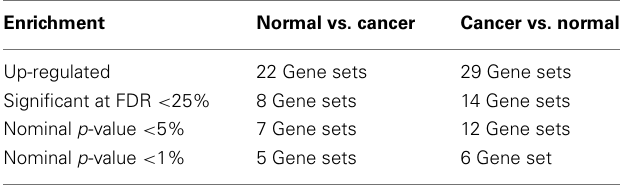
Table 1 | Summary of gene set enrichment analysis (GSEA) results for the colorectal cancer (CRC) related microarray – GSE8671, based on the 73 gene sets searched from MSigDB by using query term – “colon.”